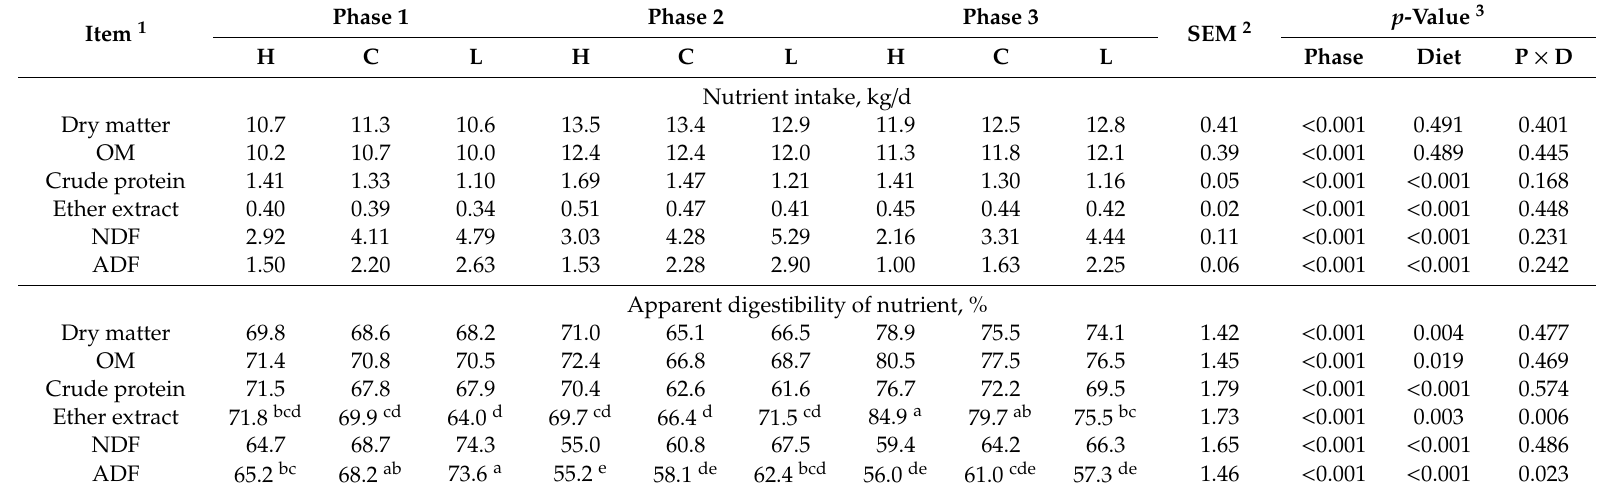
Table 2. E ff ects of dietary nutrient density on nutrient intake and apparent digestibility in the whole fattening phases of Holstein